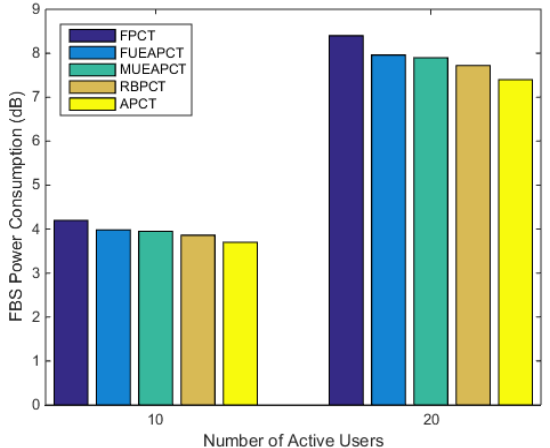
Figure 6. FBS Power Consumption Vs number of active